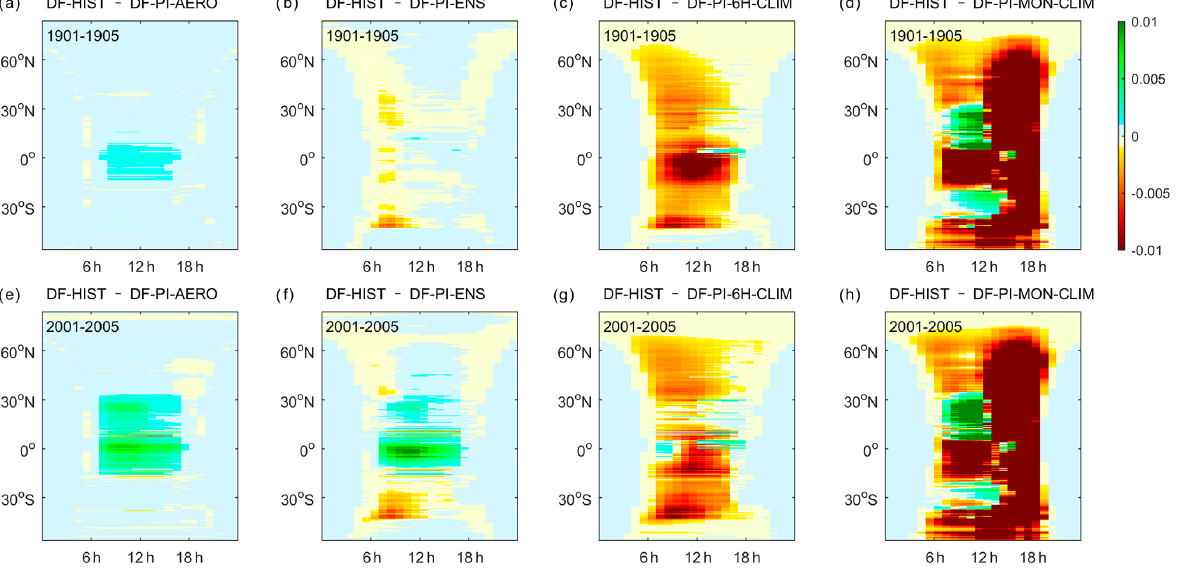
Figure 5. Diurnal variations of (cid:49) GPP in gCm − 2 h − 1 between DF-HIST and DF-PI-AERO (a, e) , DF-PI-ENS (b, f) , DF-PI-6H-CLIM (c, g) and DF-PI-MON-CLIM (d, h) during 1901–1905 (a–d) and 2001–2005 (e–h)